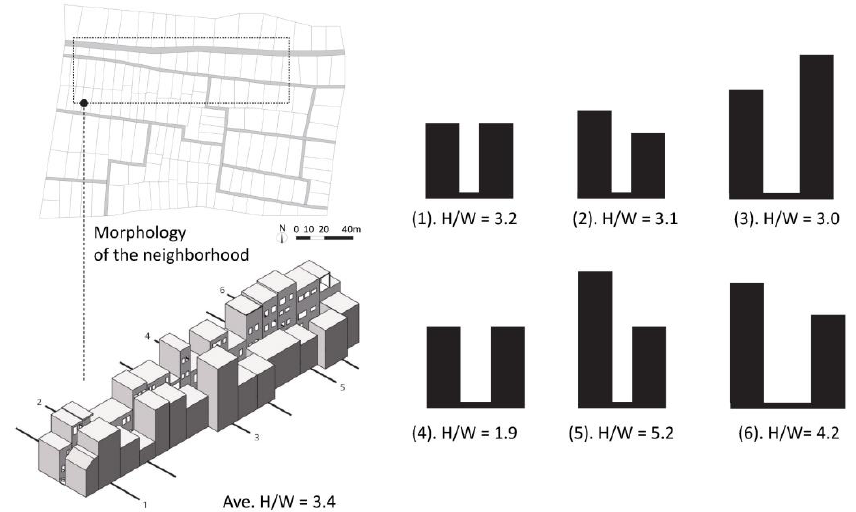
Figure 6. Sections and aspect ratio of the study street (drawn by the students).